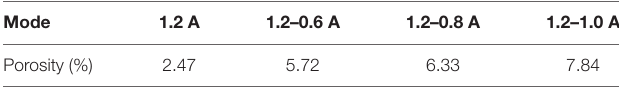
TABLE 4 | Specimen surface porosity fabricated under the different